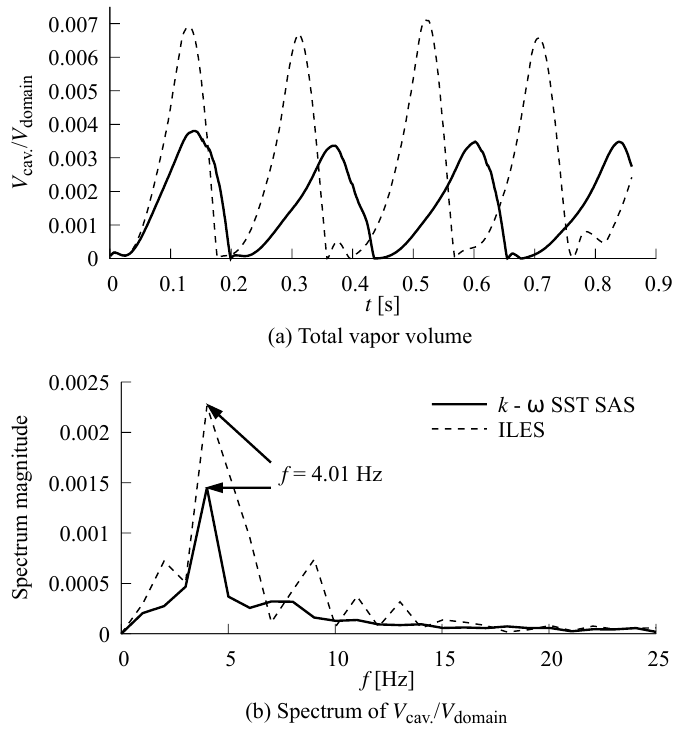
Figure 3. The total vapor variation during unsteady cavitation around a NACA66 hydrofoil with k − ω SST scale adaptive simulation (SAS) and implicit large eddy simulation